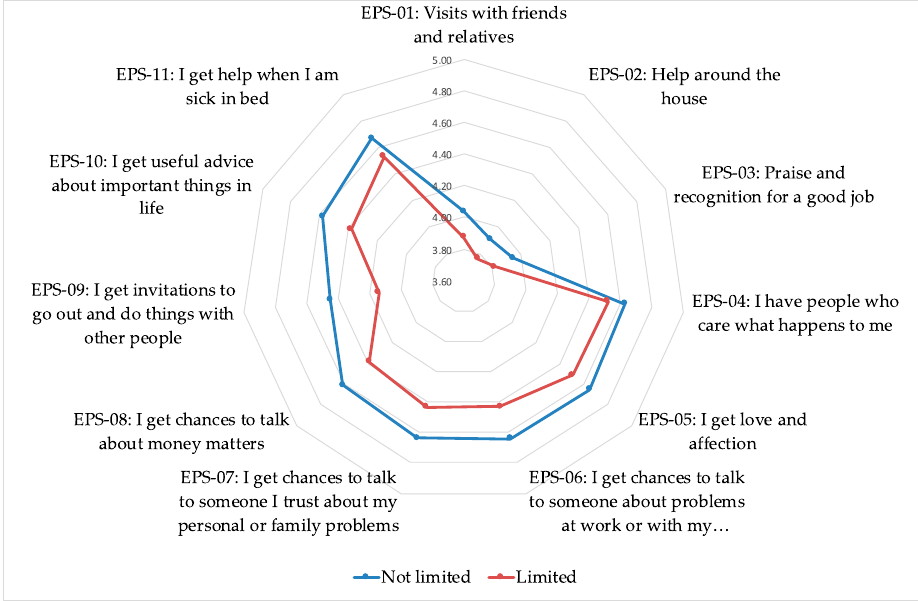
Figure 1. Average of emotional and personal support (EPS) items for limited and not limited women.